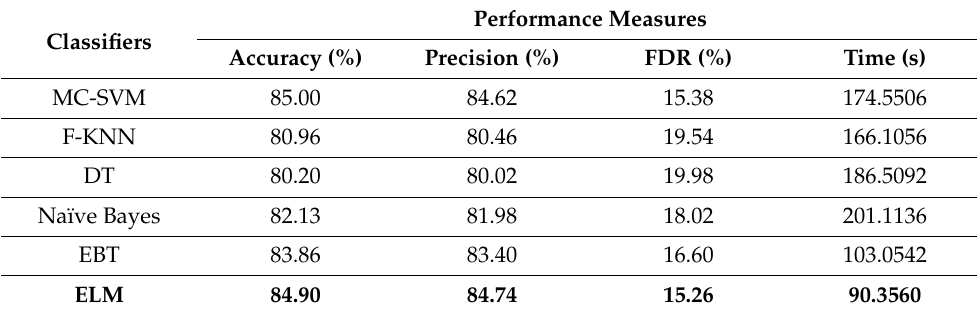
Table 3. Classification accuracy using EMI-based feature selection for HAM10000